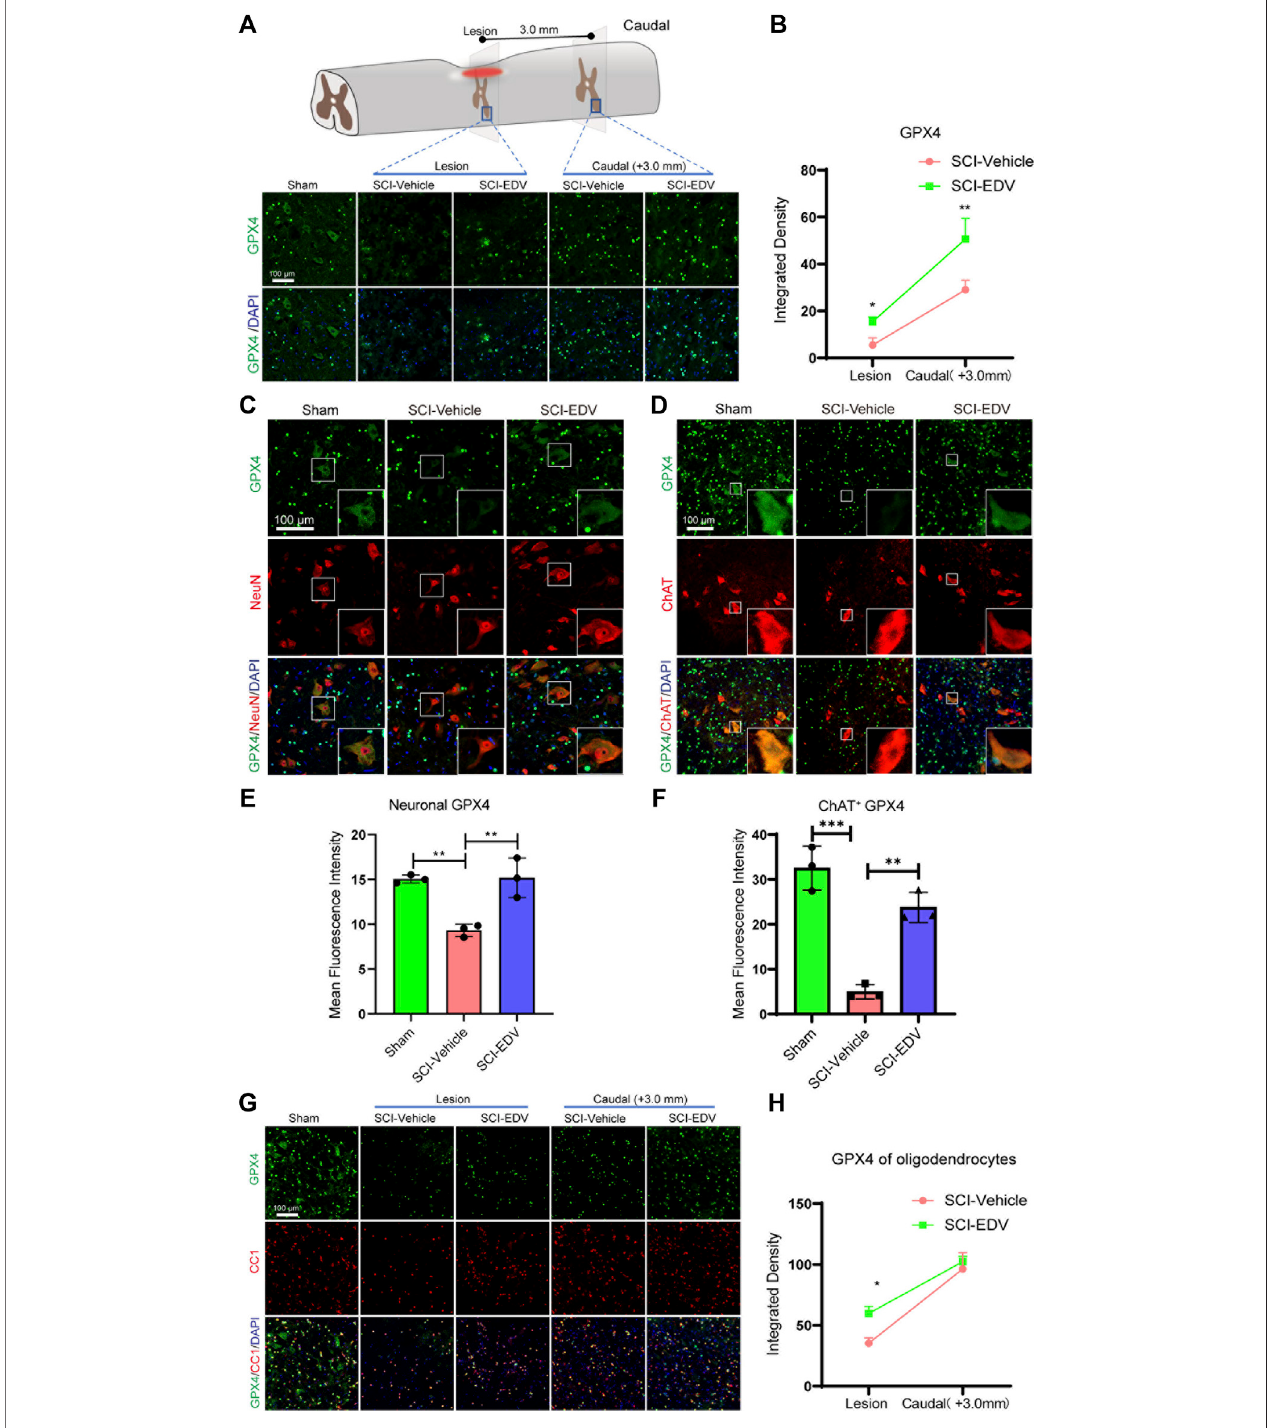
FIGURE2| EdaravoneupregulatesGPX4afterSCI (A) Upper,schematicdiagramofGPX4detectedinjuredepicenterandcaudalspinalcordventralhorn(3 mmto thelesion)at2 dayspostSCI,Lower, immuno fl uorescenceimages ofGPX4(green)inthelesionepicenterand caudalspinalcord section.NucleiwerestainedwithDAPI (blue).Scalebar,100 μ m. (B) Quanti fi cationoftheGPX4intensityinthelesionandcaudalsegment. (C,D) Representativeimmuno fl uorescenceimagesofGPX4(green)/ NeuN (red) (C) and GPX4 (green)/ChAT (red) (D) in the caudal spinal cord at 3.0 mm to the lesion at 2 days post SCI. Scale bar,100 μ m. (E,F) Quanti fi cation of Neuronal (NeuN positive) GPX4 (E) and Motor neuronal (ChAT positive) GPX4 (F) . (G) Representative immuno fl uorescence images of GPX4 (green)/CC1 (red) in both lesion epicenter and in the caudal spinal cord at 3.0 mm to the lesion at 2 days post SCI. Scale bar,100 μ m. (H) Quanti fi cation of oligodendrocyte (CC1 positive) GPX4. Dataare expressed asmean± standarddeviation.Statisticalsigni fi cancewasdeterminedbytwo-way ANOVAwithSidak ’ smultiplecomparisons test (B,H) orone-way ANOVA with Tukey ’ s post hoc test (E,F) . * p < 0.05, ** p < 0.01, and *** p < 0.001, n = 3, bar = 100 μ m.